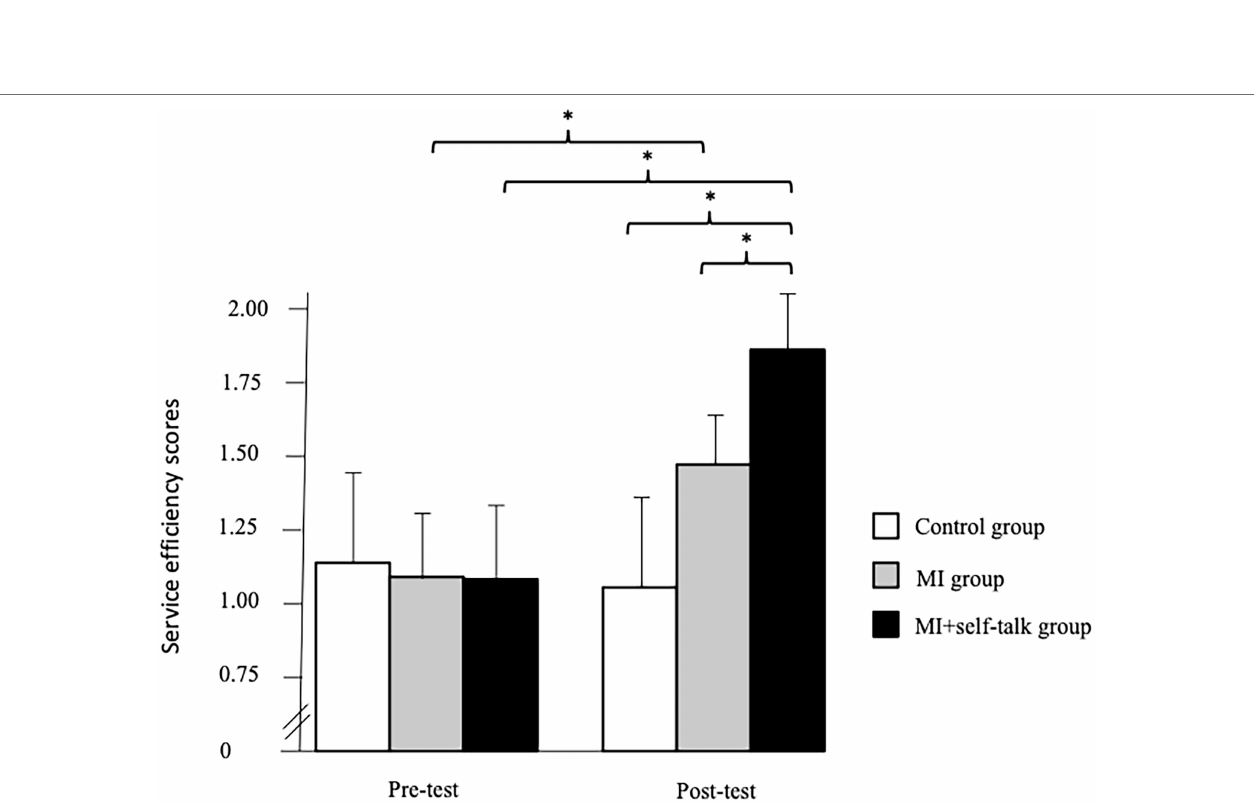
FIGURE 1 | Significant interaction between the group and the phase (* p < 0.05) concerning the percentage of service success. Motor imagery (MI).